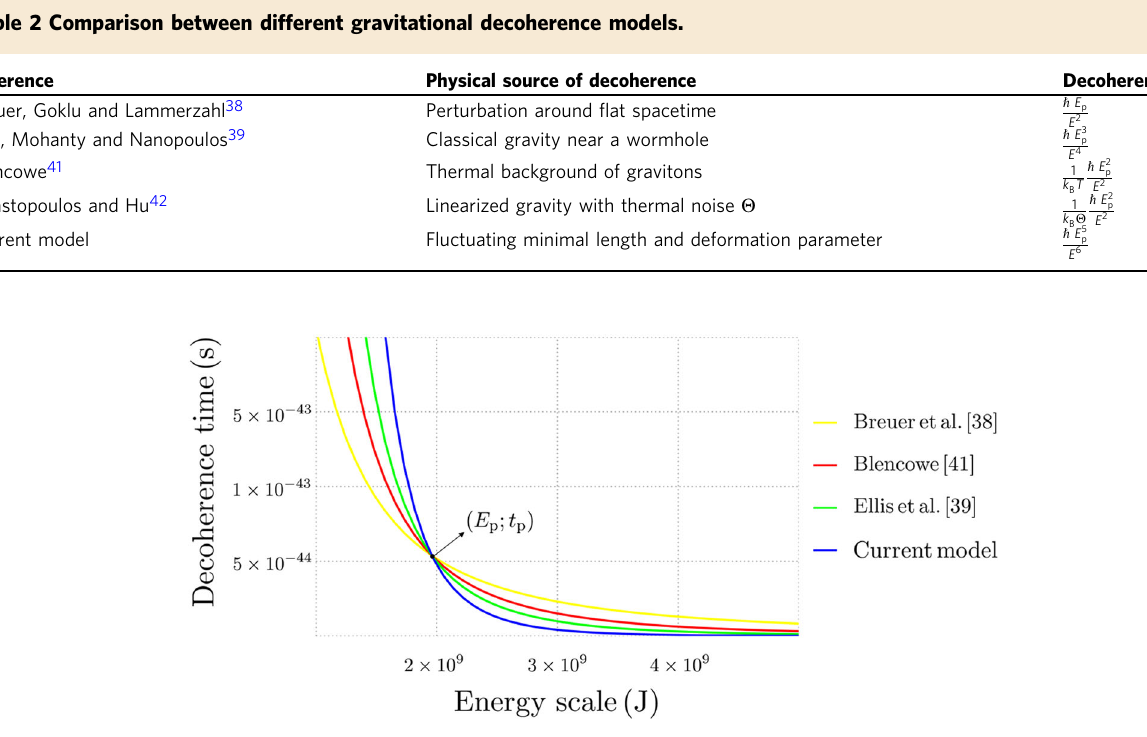
Fig. 2 Behavior of the decoherence time as a function of the energy scale for different gravitational decoherence mechanisms. Both quantities are expressed in international units. All curves intersect exactly at the Planck energy: E = E p . For comparison purposes, for the model developed in ref. 41 we have required the thermal background of gravitons to yield a contribution compatible with the energy of the analyzed quantum system, that is k B T ≃ E